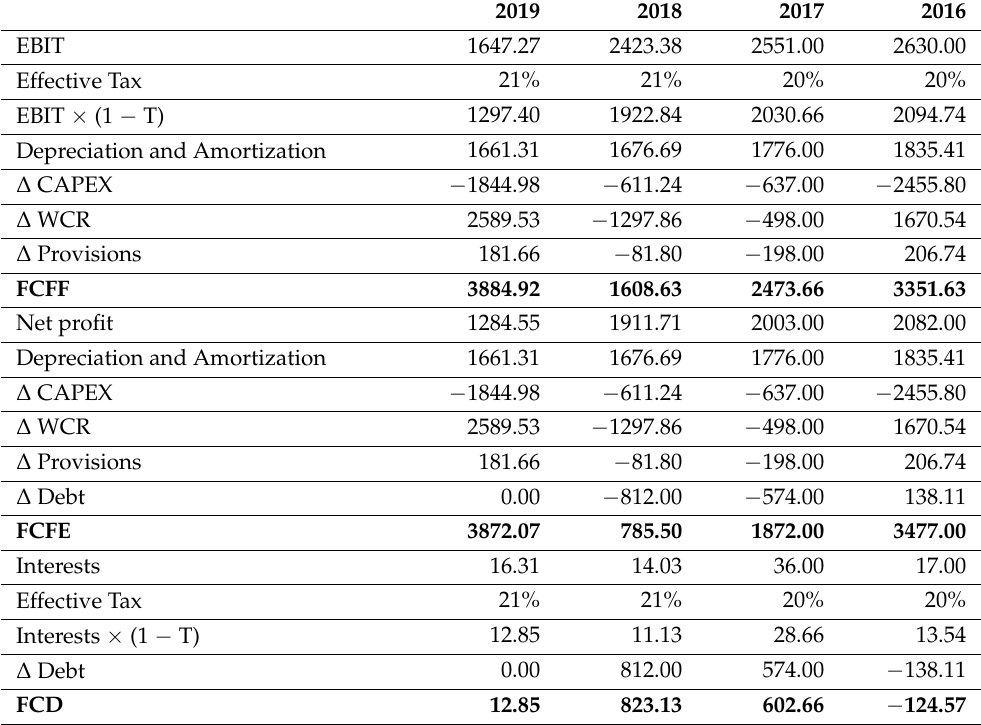
Table 8. Formation of FCFF, FCFE and FCD flows and the components affecting them in Geotermia Mazowiecka S.A. (PLN thousand).